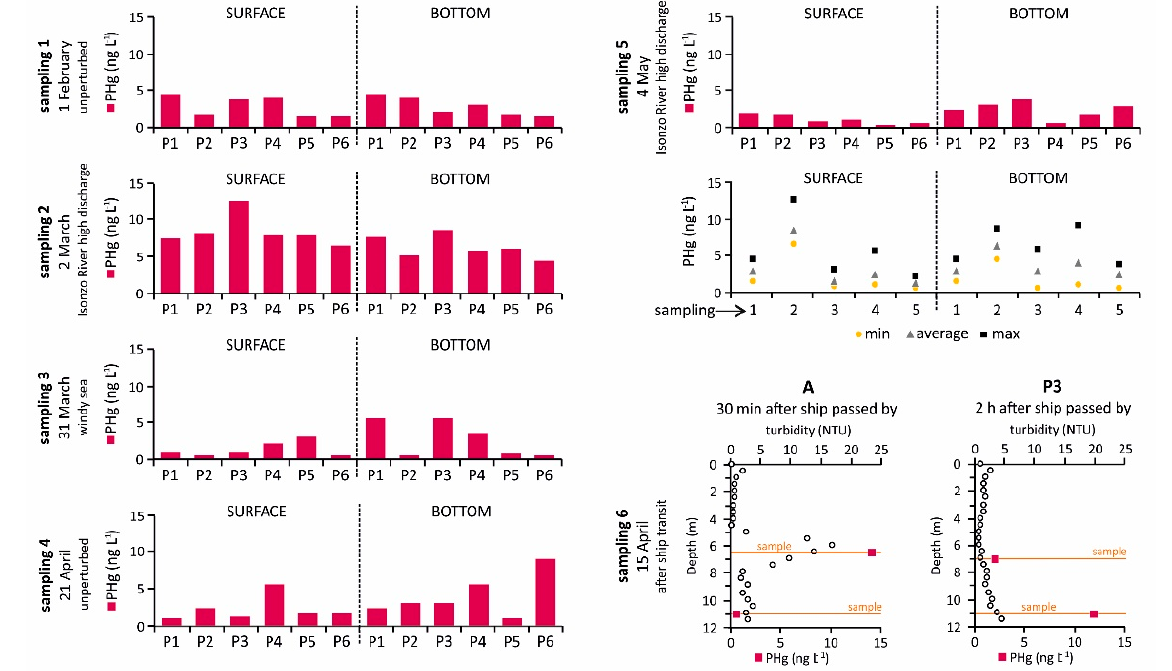
Figure 6. Concentration of PHg (ng L − 1 ) in the surface and bottom water samples collected at the six investigated sites in the Bay of Panzano under different environmental conditions during sampling campaigns 1–5 and concentrations of turbidity (NTU) and PHg (ng L − 1 ) along the water column at sites A and P3 after a ship had sailed out of the area during sampling campaign 6.